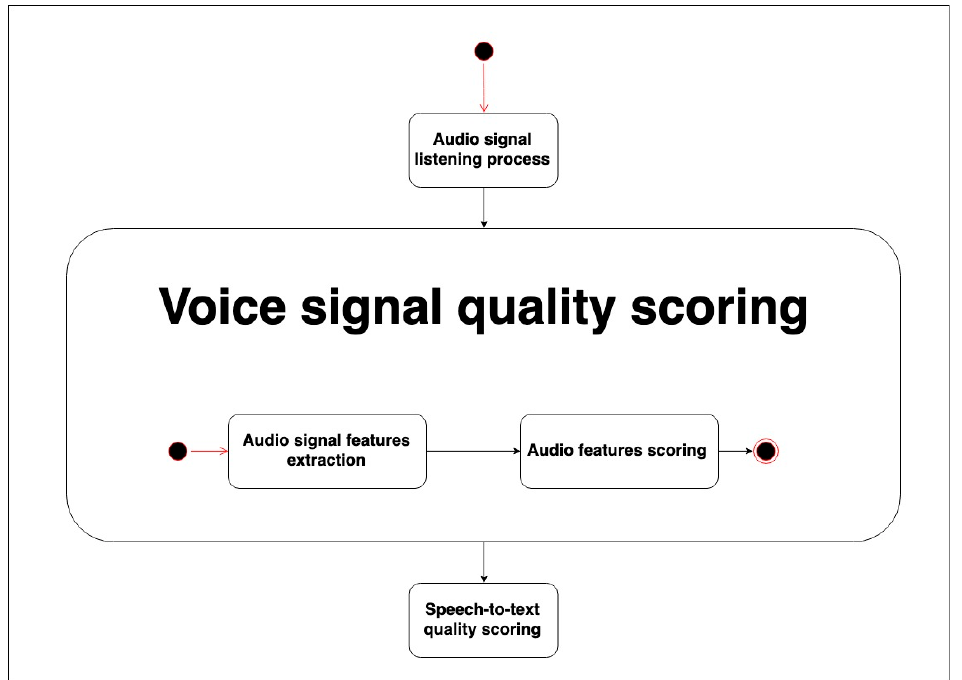
Figure 1. Process model of the voice signal quality scoring